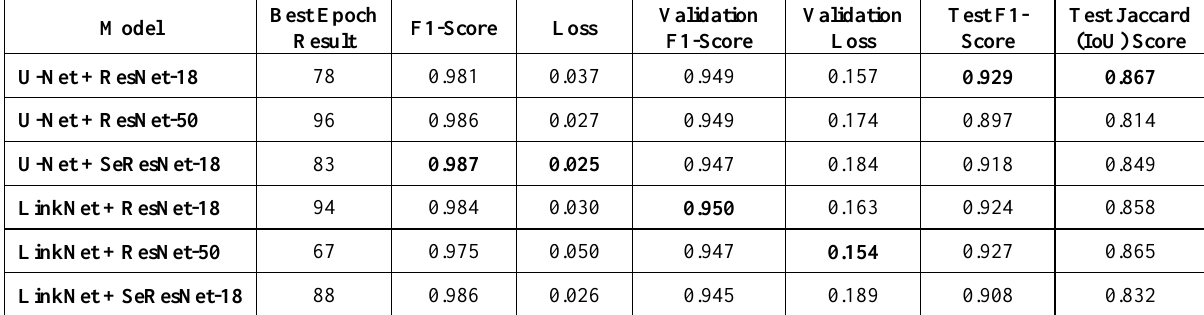
Table 2. The performance results obtained from the true orthophotos (image only results).